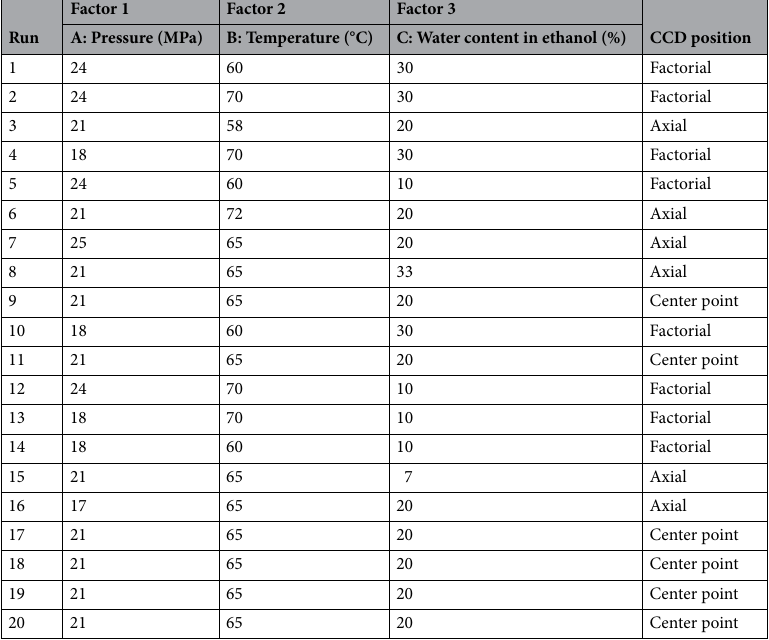
Table 3. CCD experimental design for the SFE of G. procumbens.